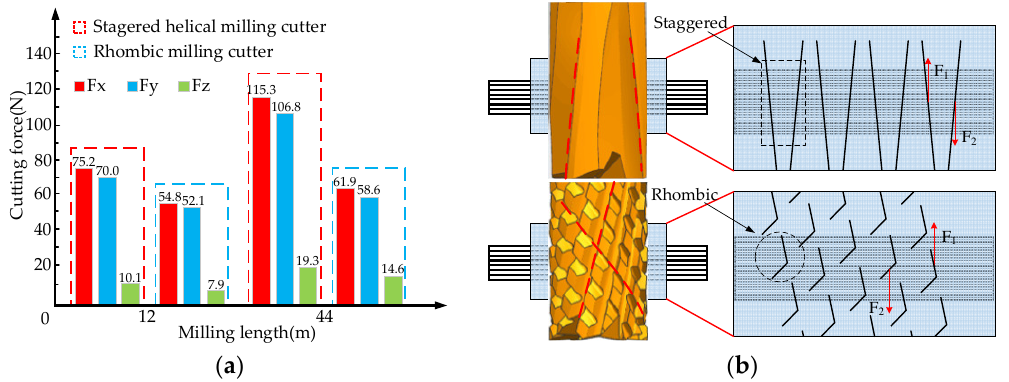
Figure 8. The analysis of cutting force and state of two kinds of milling cutters, ( a ) cutting forces measurement with the cutting length being 12 m and 44 m, respectively, and the ( b ) comparison of the cutting state in milling CFRP with the two styles of cutting tools.